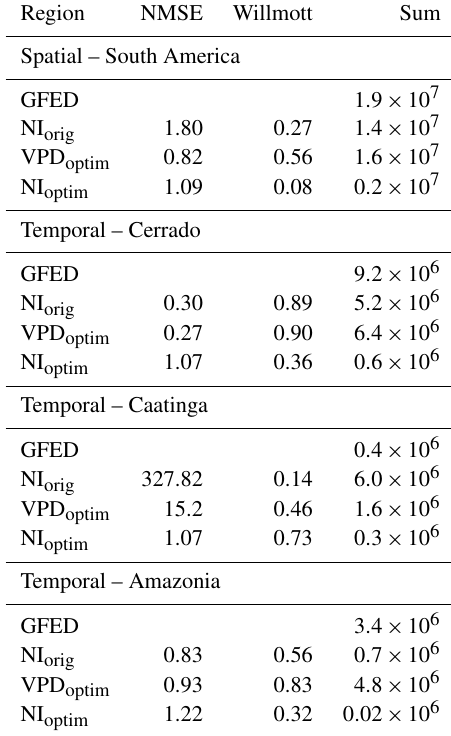
Table 1. Comparison of the burned area results in terms of NMSE, the Willmott coefficient of agreement, and the sum (hayr − 1 ) be- tween NI orig , VPD optim , NI optim , and the GFED evaluation data.